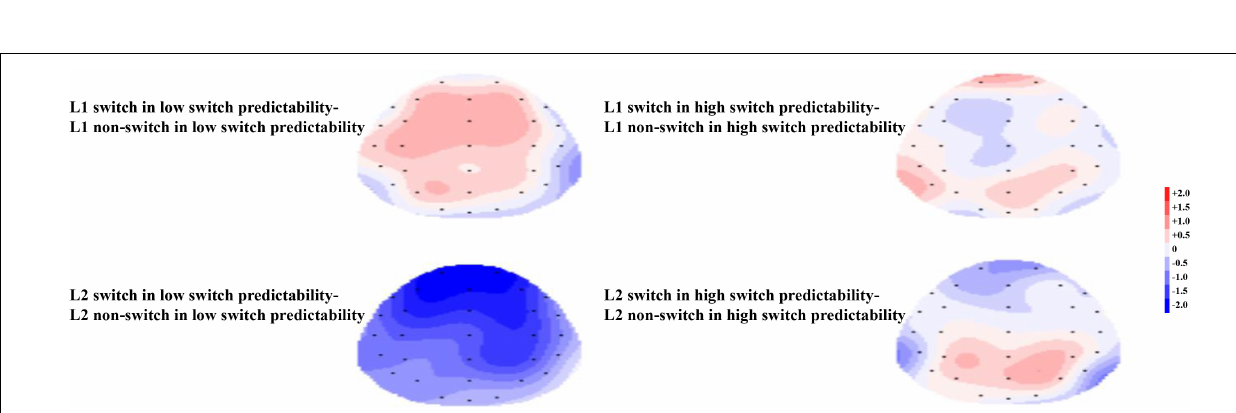
FIGURE 6 | (Left) For the low switch predictability condition, the topographical maps of the early phase for the distribution of the difference between the same language in different transition trials, i.e., switch trials minus non-switch trials. (Right) For the high switch predictability condition, the topographical maps of the early phase for the distribution of the difference between the same language in different transition trials, i.e., switch trials minus non-switch